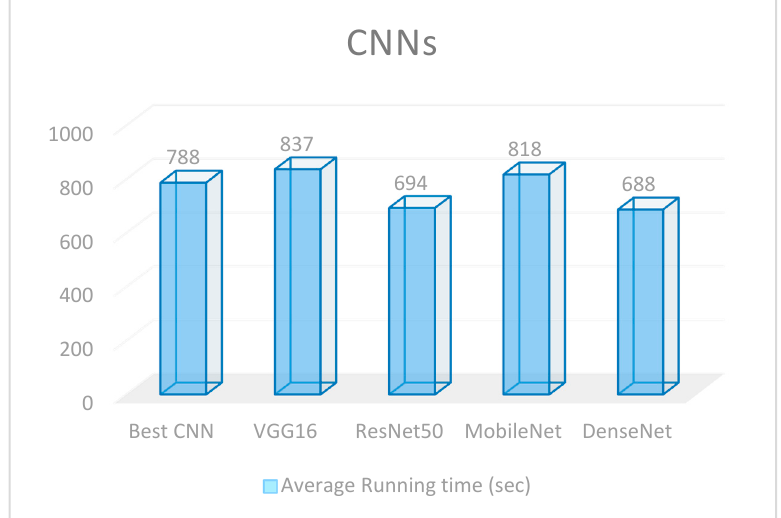
Figure 8. Average run time for the compared best CNN architectures.